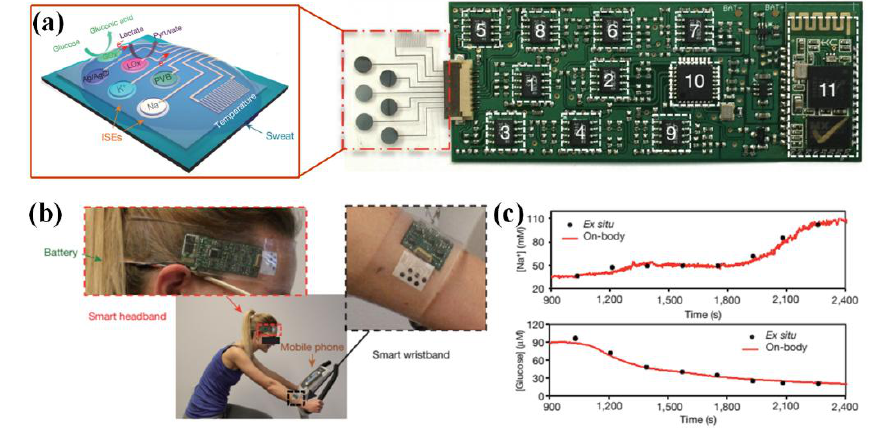
Figure 5. Detection of metabolism parameters: ( a ) the sensor array for simultaneously and selectively measuring the Na + , K + , glucose and lactate in sweat; ( b ) the devices worn in forehead and wrist to monitor the stationary cycling process; ( c ) the detected concentrations of Na+ and glucose, which were compared with the Ex situ calibration data. Adapted with permission from [15], Copyright (2016) Nature.